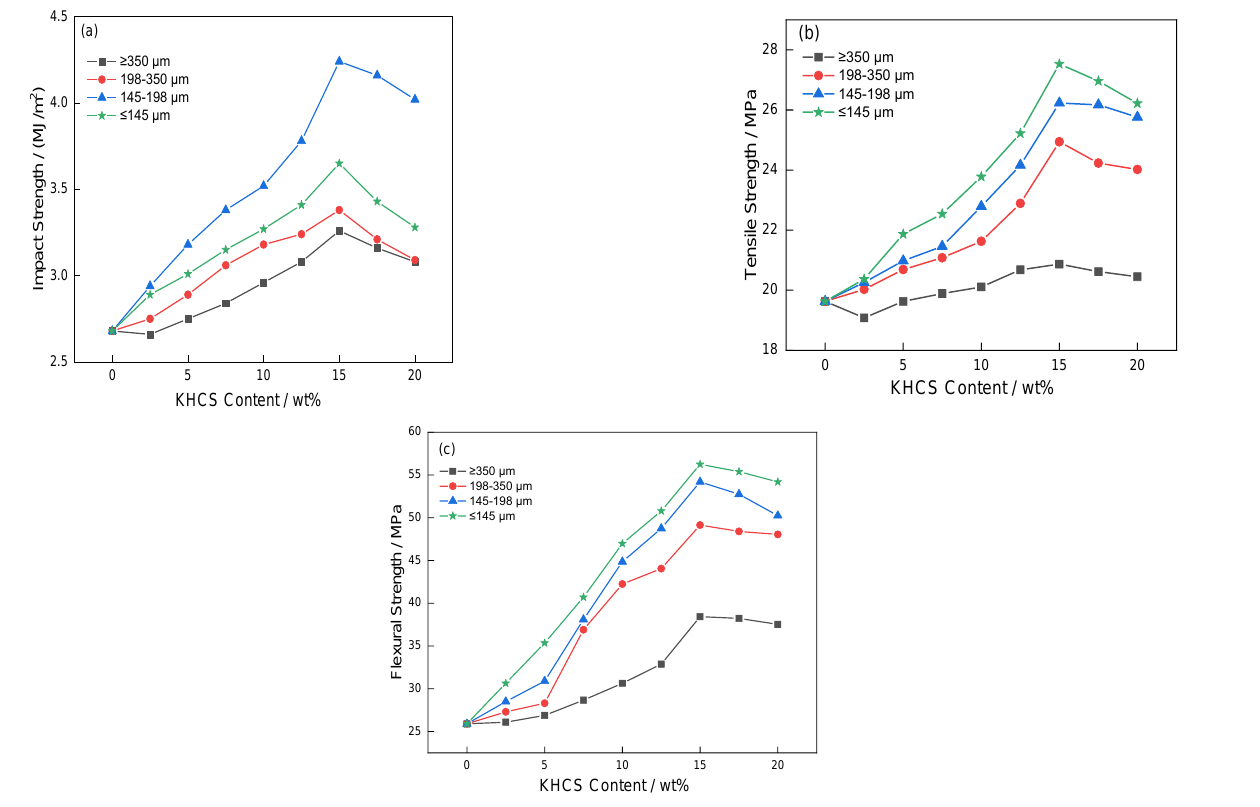
Figure 3. Effects of different particle sizes and contents of KHCS on mechanical properties. ( a ) Impact strength; ( b ) Tensile strength; ( c ) Flexural strength.